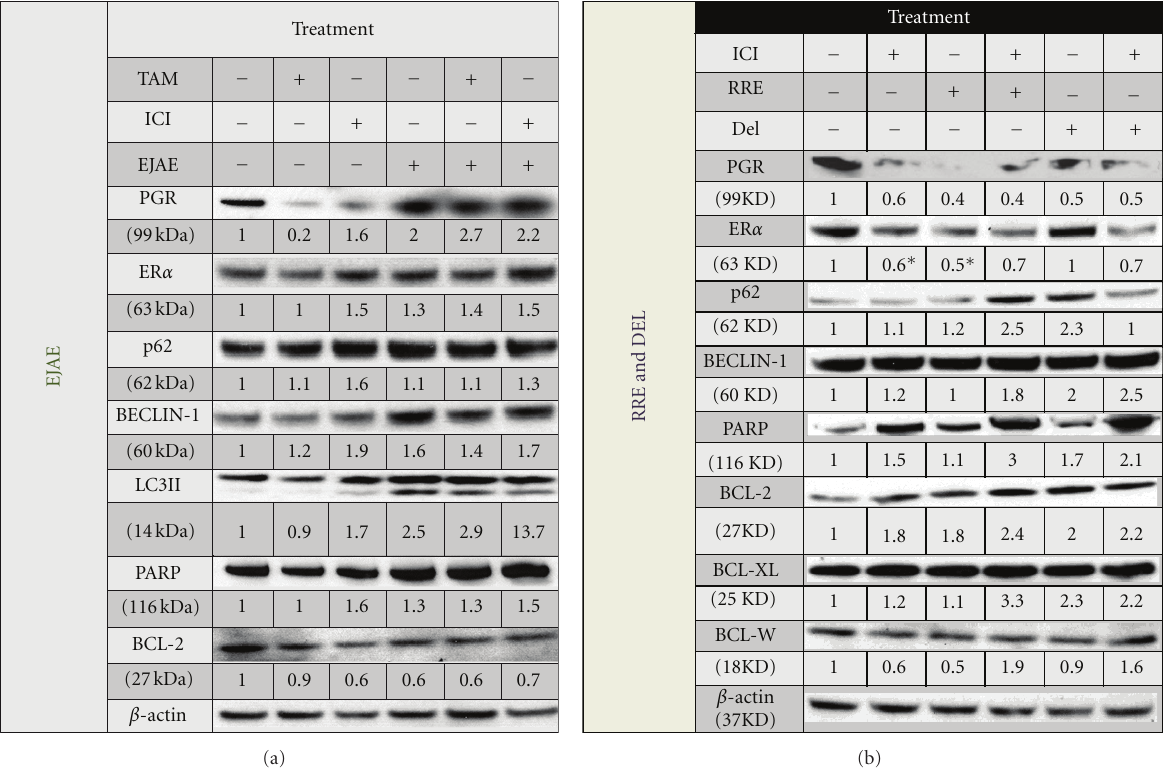
Figure 5: (a) and (b) E ff ect of EJAE and RRE on the expression of nuclear receptors and cell-death markers in ICI-resistant (LCC9) cell lines. Biomarker analysis results after 3d treatment of EJAE with and without drug treatments. Data represented as fold change over the vehicle. All treatments were normalized to vehicle treatment (first lane). Vehicle treatment contained 0.01% EtOH and 0.1% DMSO. Concentrations of treatments were as follows: TAM (4-0HT) = 100nM; ICI = 1nM; EJAE = 100 μ g/mL; RRE = 10 μ g/mL; and DEL = 1 μ M. Concentration of extract used showed the most significant reduction in cell proliferation of LCC9 cells after 6d treatment. Each extract or polyphenol used for treatment was diluted 1000-fold from stock concentration. ∗ designates a significance of P ≤ 0 . 05 compared to vehicle